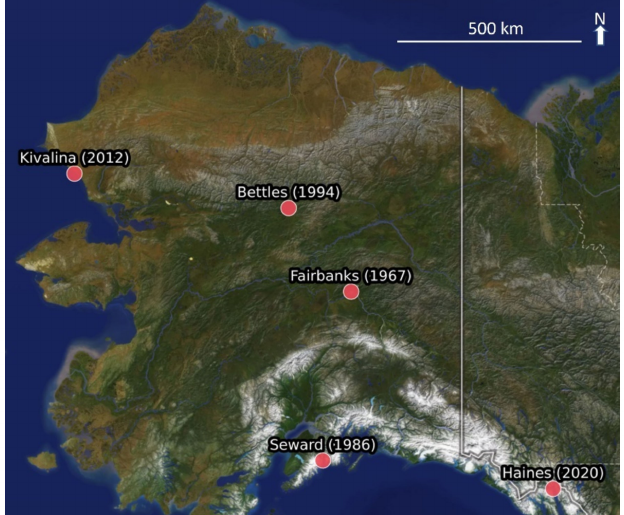
Figure 1. Locations and dates (year) of the five flood events. This figure was created with © CARTO (https://carto.com/, accessed on 27 January 2022). The background map uses data from © Mapbox and © OpenStreetMap and their data sources. Additional details at https://www.mapbox. com/about/maps/ (accessed on 27 January 2022) and http://www.openstreetmap.org/copyright (accessed on 27 January